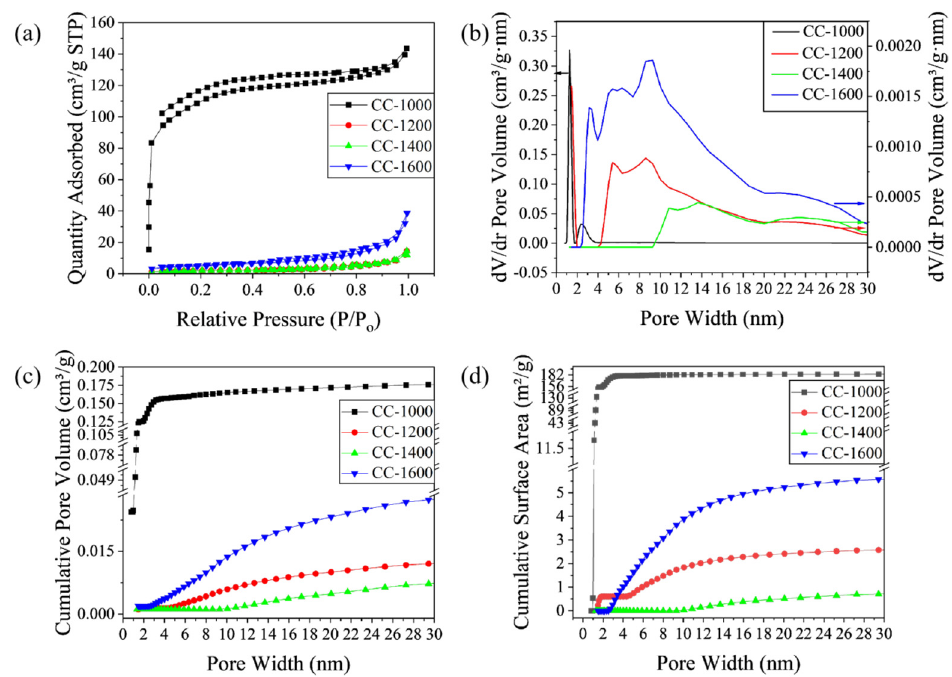
Figure 4. ( a ) Nitrogen adsorption/desorption isotherms; ( b ) Pore size distribution curves based on NLDFT model; ( c ) cumulative pore volume; and ( d ) cumulative surface area of different corncob hard carbon materials.